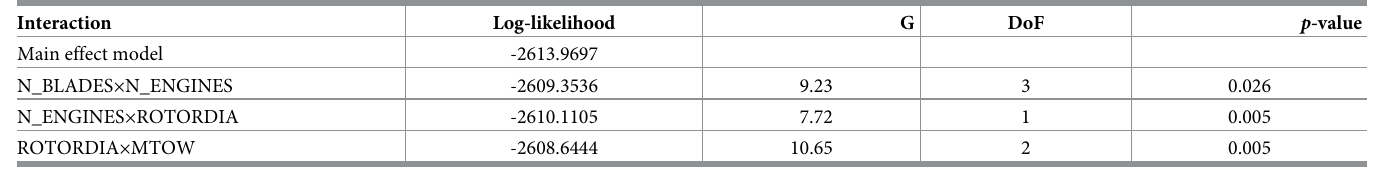
Table 4. Statistical significance test for the addition of interactions (one at a time) to the main effect model of turboshaft helicopter accidents.